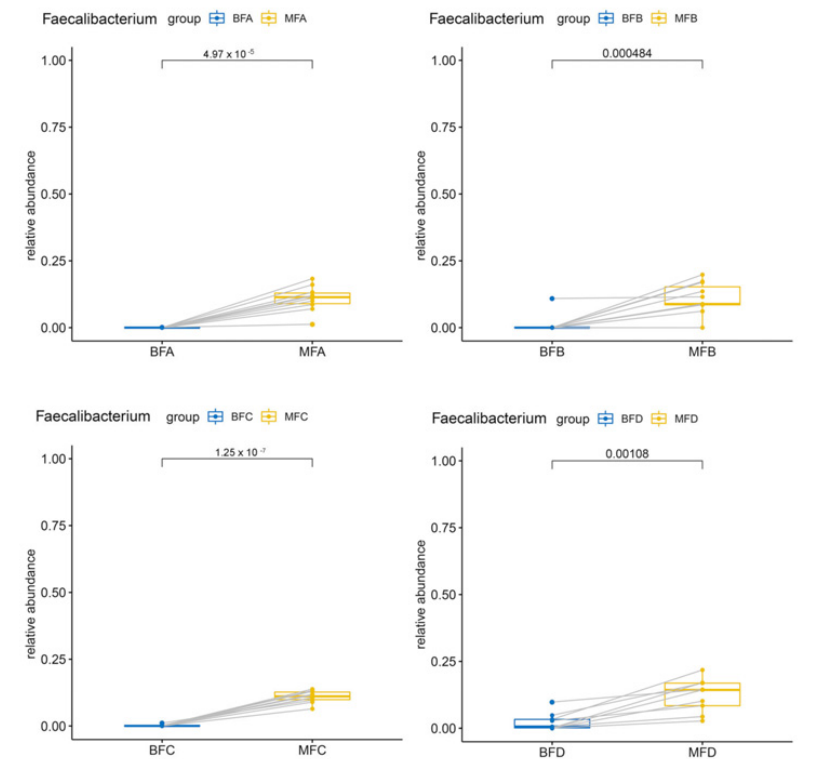
Figure 6. Different Faecalibacterium in maternal and infant feces. The two points connected by a line are the same mother-infant pair. MFA: maternal feces (corresponding to infant younger than one month of age), MFB: maternal feces (corresponding to infant between one and three months of age), MFC: maternal feces (corresponding to infant between three and six months of age), MFD: maternal feces (corresponding to infant between six and 12 months of age), MFE: maternal feces (corresponding to infant older than 12 months of age), BFA: infant feces younger than one month of age, BFB: infant feces between one and three months of age, BFC: infant feces between three and six months of age, BFD: infant feces between six and 12 months of age, BFE: infant feces older than 12 months of